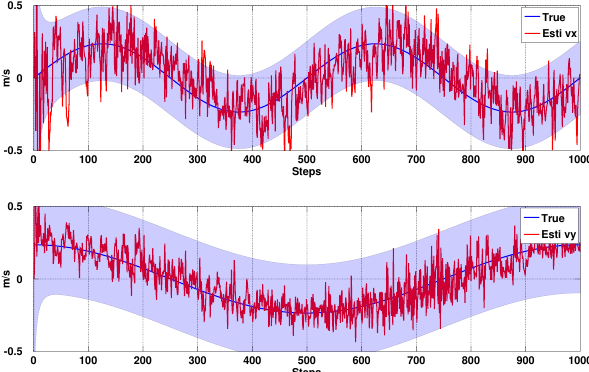
Figure 9. Simulation results for PBVS tracking: velocity estimation. W ˆ˙ x and W ˆ˙ y with 3 σ confidence boundary.